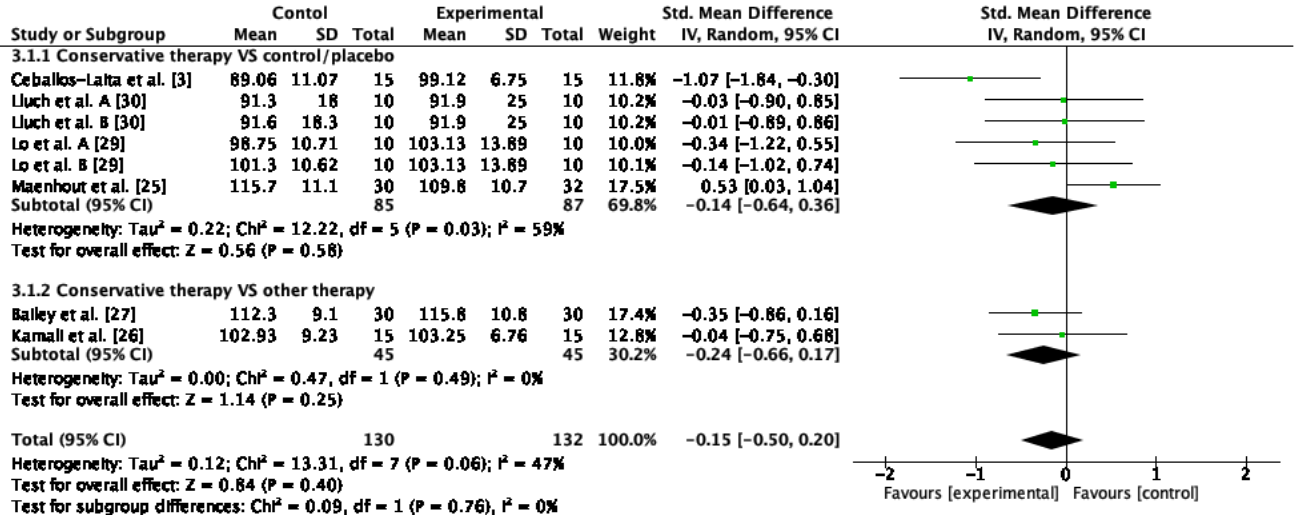
Figure 4. Forest plot of external rotation ROM for conservative therapy versus control/sham and combination of conservative therapies versus conventional therapy in isolation. Lluch et al. A. compared manual therapy versus control intervention. Lluch et al. B compared the manual contact versus control intervention. Lo et al. A compared KT versus control intervention. Lo et al. B compared stretching versus control intervention.